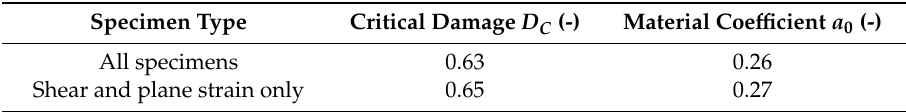
Table 5. Critical damage values for the Oyane